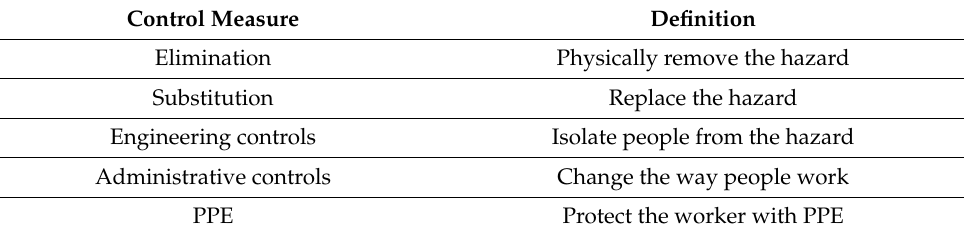
Table 3. Hierarchy of Controls representation.